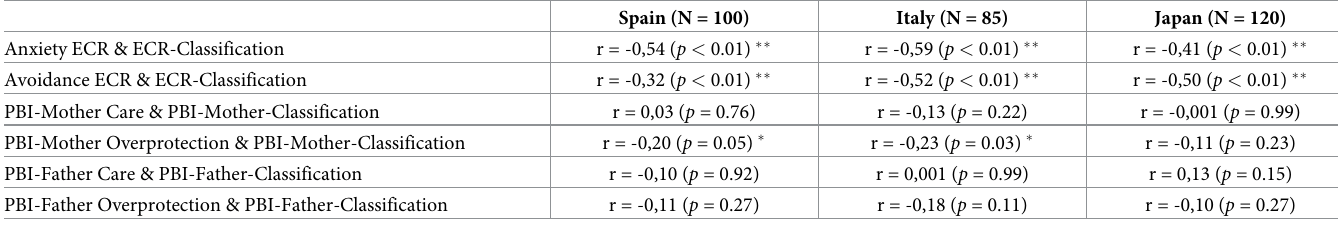
Table 6. Spearman’s r correlations between ECR and PBI factors and classifications.